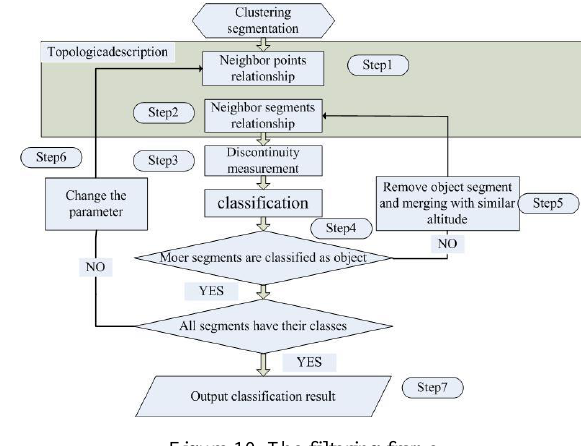
Figure 10. The filtering